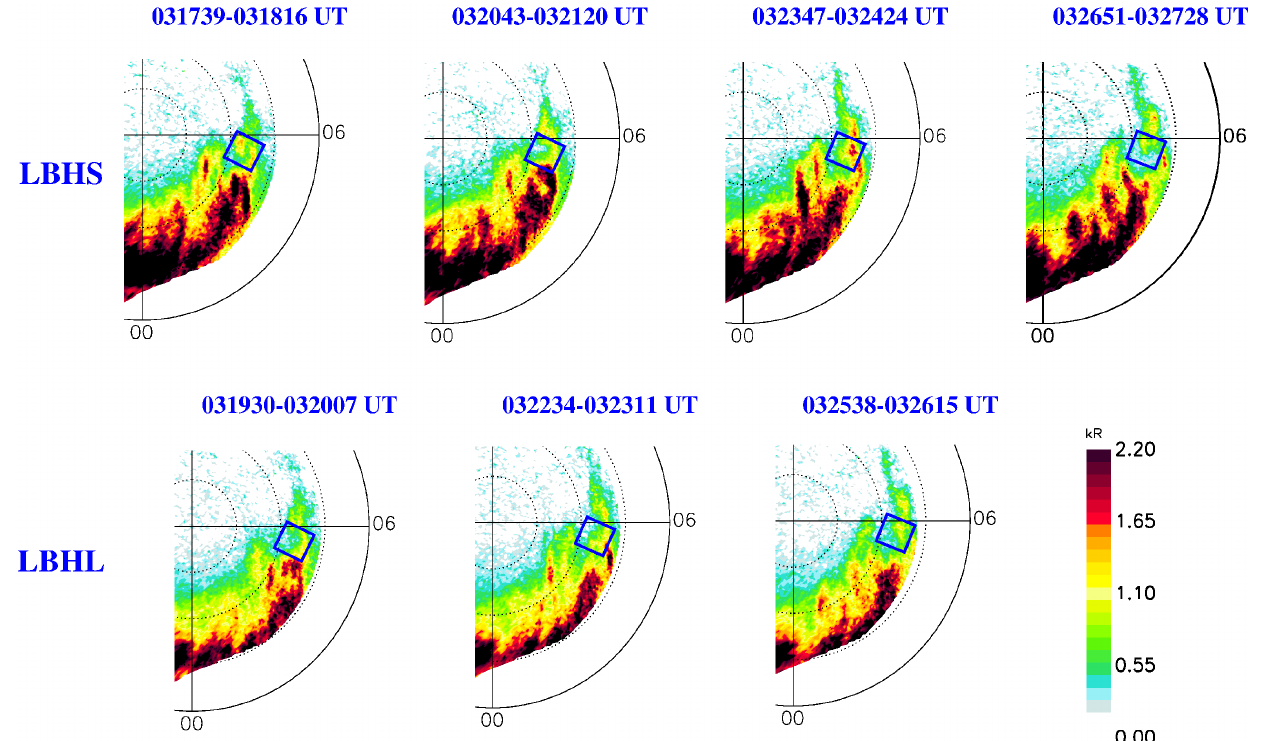
Fig. 4. Global UVI emissions in the morning sector. The MIRACLE area displayed in Fig. 3 is marked by the blue